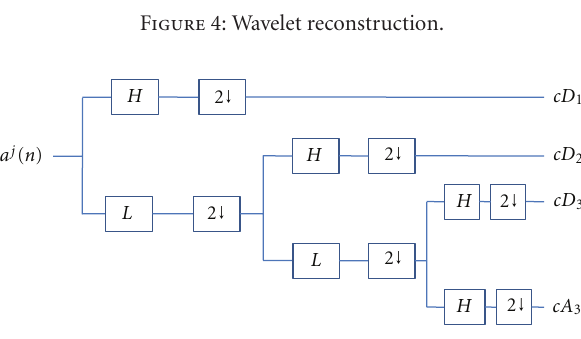
Figure 5: Wavelet multiresolution analysis.